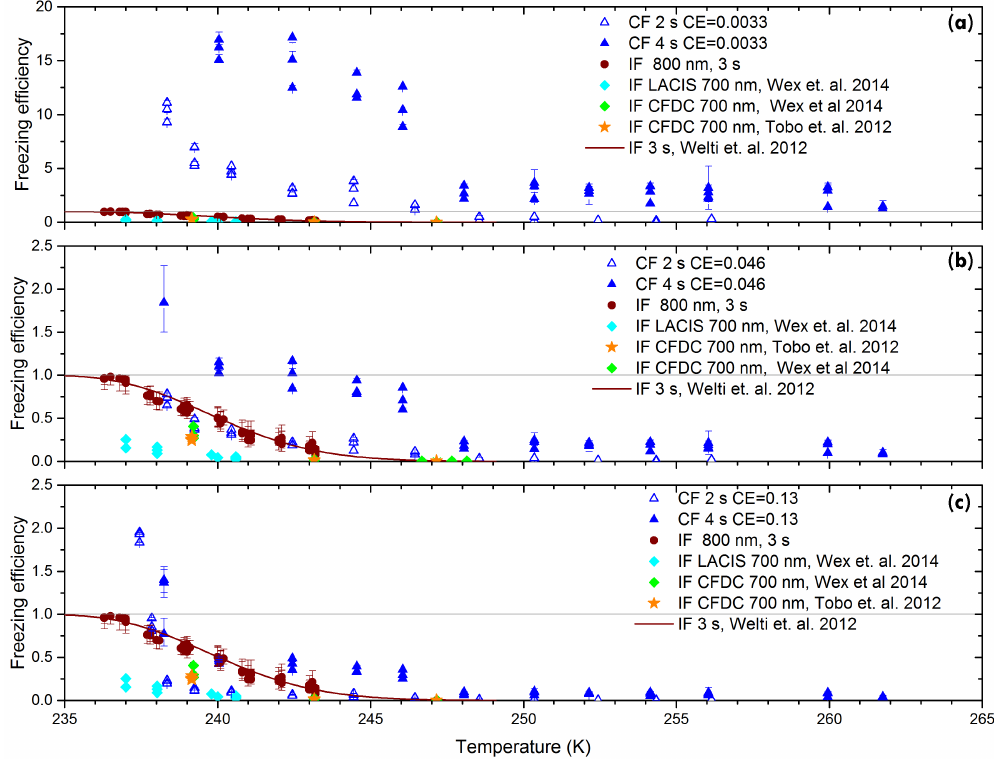
Figure 6. Freezing efficiency for 800nm kaolinite particles with a concentration of 1000cm − 3 calculated with 3 different assumptions for CE: panel (a) , with the theoretical CE from Park et al. (2005) and Wang et al. (1978); panel (b) , with 14 × CE from panel (a) ; panel (c) , with CE = 0 . 13 (applying the value of 200nm AgI particles) for lower bound of freezing efficiency. Each triangle represents an independent measurement. Error bars represent the precision of the IODE detector. Brown circles show the freezing efficiency of droplets in ZINC for a residence time of 3s for 800nm kaolinite particles. Orange stars show immersion freezing of droplets activated by 700nm Fluka kaolinite particles (from Fig. 2a of Tobo et al., 2012). Light blue diamonds show immersion freezing of droplets activated by a 700nm Fluka kaolinite particle (LACIS data with 1.6s residence time (from Fig. 2 (right panel) of Wex et al., 2014)). The green diamond shows immersion freezing of droplets activated by 700nm kaolinite particles (CFDC data with 5s residence time (from Fig. 2 (right panel) of Wex et al., 2014)). The brown line represents the α -pdf parameterization from Welti et al. (2012). The gray horizontal line indicates the maximum freezing efficiency. Note that the y scale for panel (a) is different from the ones in panels (b) and (c)